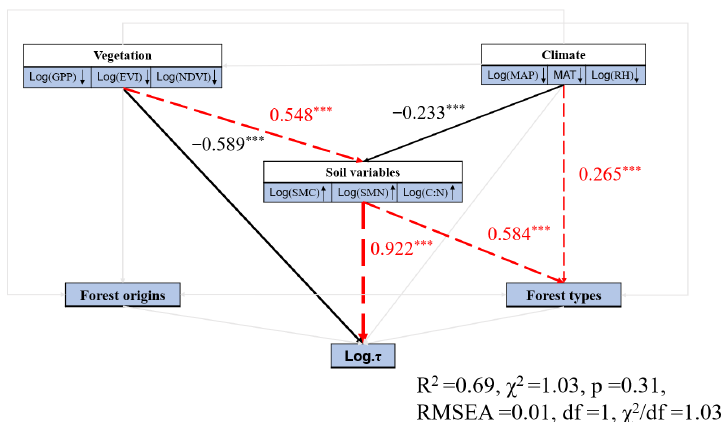
Figure A4. A conceptual model of the overall effects of environmental variables on different forest types τ. Climate variables include MAT, MAP, and RH. Vegetation variables include NDVI, GPP, and EVI. Soil variables include SMC, C:N, and SMN. The symbols “ ↑ ” and “ ↓ ” indicate a positive or negative correlation between environmental factors and subsoil τ.